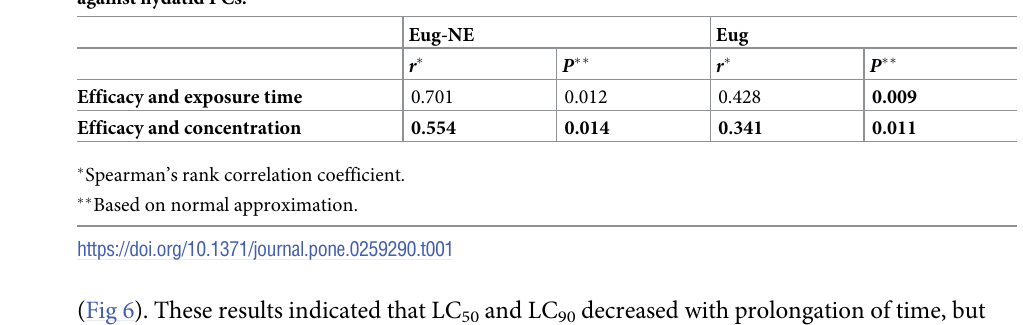
PLOS ONE | https://doi.org/10.1371/journal.pone.0259290 November11,